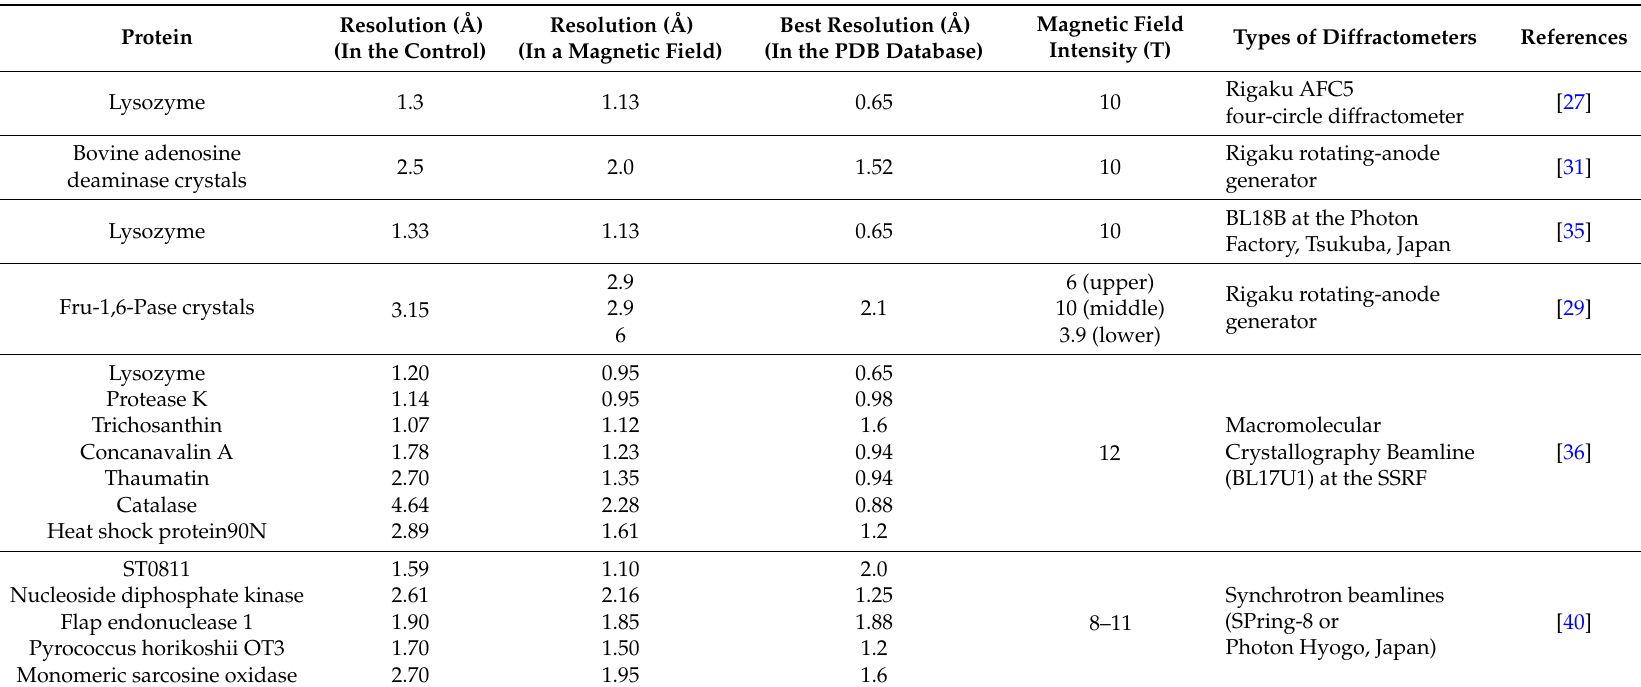
Table 3. A resolution comparison of crystals grown inside and outside of the magnetic